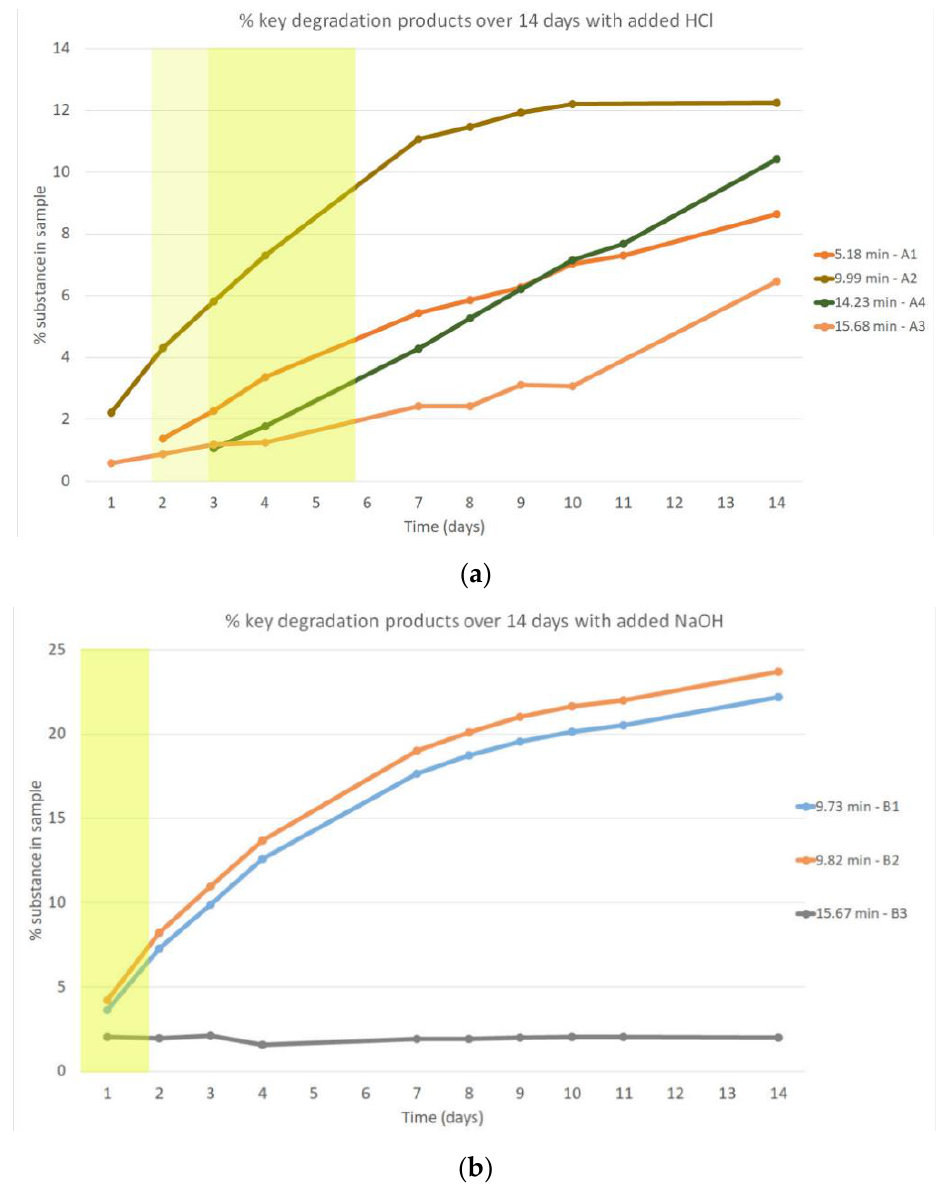
Figure 3. ( a ) Key degradation products of venetoclax in acidic conditions (1 M HCl, 50 °C) represented with a line chart depicting their increase in sample over time. A zone where a total degradation of 5–20% was obtained is marked with a yellow rectangle. A zone where a total degradation of 10–20% was obtained is marked with a darker yellow rectangle. ( b ) Key degradation products of venetoclax in basic conditions (1 M NaOH, 50 °C) represented with a line chart depicting their percentage in sample over time. A zone where a total degradation of 10–20% was obtained is marked with a darker yellow rectangle.